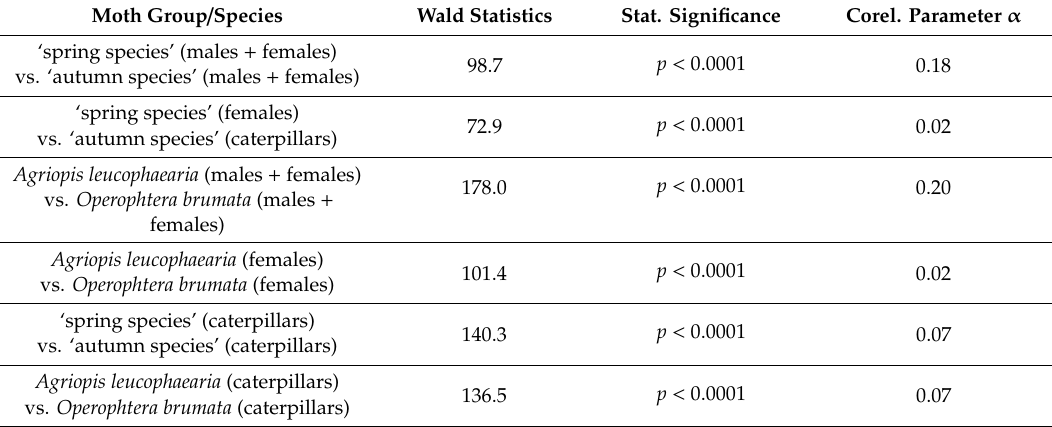
Table 2. Results of paired comparisons between moth groups or moth